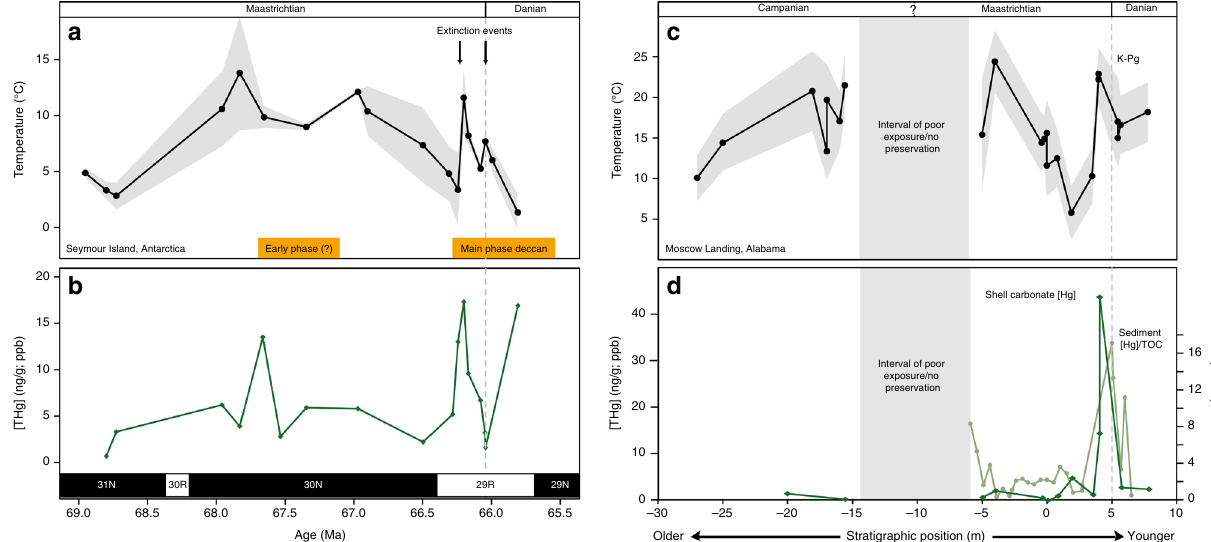
Fig. 2 Coastal marine temperature and mercury concentration time series. Δ 47 -derived coastal marine temperatures ( a , b ) and [Hg] records ( c , d ) for Seymour Island, Antarctica 27 and Moscow Landing, Alabama 28 . The age model for Seymour Island was derived from combined biostratigraphy, magnetostratigraphy 55 , strontium isotope chemostratigraphy 56 , and the presence of the Ir anomaly to demarcate the K – Pg Boundary 57 , as described in previous studies 27 . The K – Pg boundary at Moscow Landing is an unconformable contact, and the entire section is likely only a portion of what is preserved at Seymour Island. Nonetheless, at both sites we observe a close coupling between elevated [Hg] and temperatures immediately prior to the boundary. Uncertainties on any single sample [Hg] value are, on average, ±11% of the measured [Hg] value and often too small to depict (please refer to Methods). Uncertainties on the Δ 47 -derived marine temperatures are calculated at 1 S.E. and depicted as shaded regions adjacent to enveloping the data. The extinction events depicted at Seymour Island, Antarctica are based on macrofossil occurrence patterns from that locality 55,58 . These temperatures all compare well to existing δ 18 O-derived temperature proxies 55,59,60 . Source data are provided in Supplementary Data Files 1, 2 and